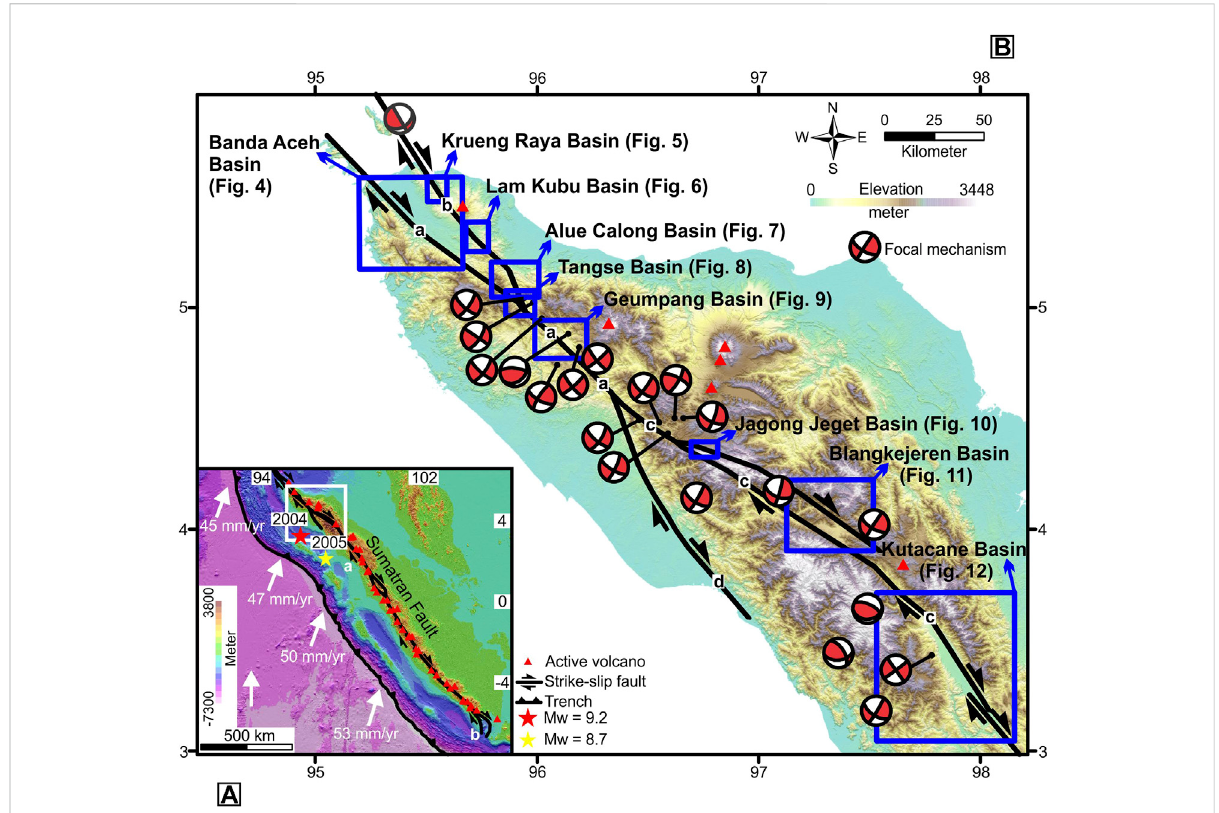
FIGURE 1 Map of: (A) tectonic features of Sumatra showing the locations of Singkel Basin (a), Sunda Strait (b), and the epicentres of 2004 and 2005 megathrust earthquakes. The convergence rates and directions are referring to Delescluse and Chamote-Rooke (2007). (B) Regional map of the Northern Sumatran Fault and the study locations. The analyzed basins are indicated in the blue rectangles. The main faults in this region are the Aceh(a),Seulimeum(b),Tripa(c),andBatee(d)Faults.FocalmechanismsarefromGlobalCentroidMomentTensordatabase(Dziewonskietal., 1981; Ekström et al.,